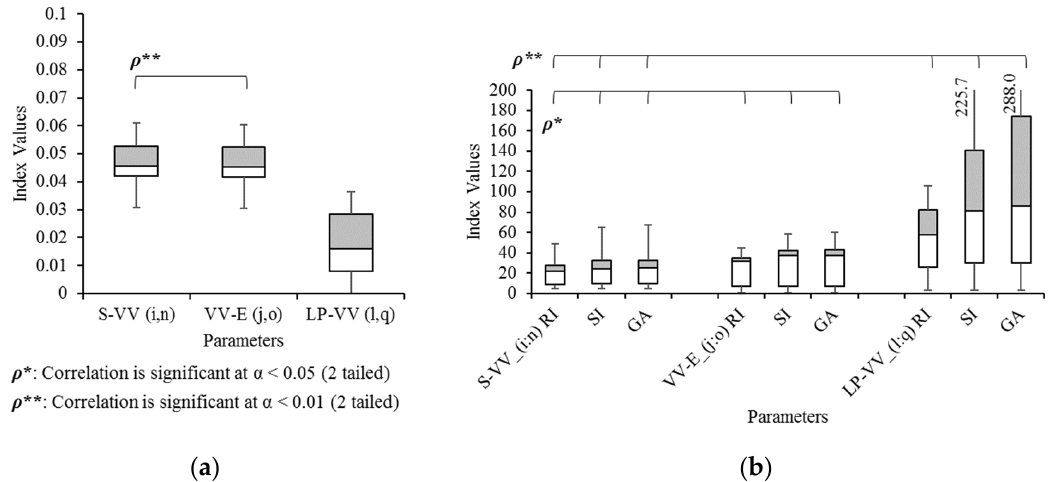
Figure 13. Box and Whisker diagrams of ( a ) the average vertical displacements of the head and ( b ) their gait symmetry indices.